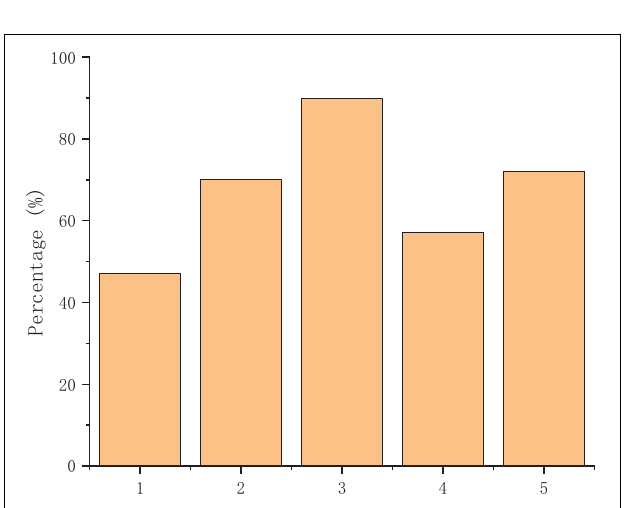
FIGURE 7 | Achievements of the hybrid learning of MOOCs [(1) deepening the feelings with teachers and classmates; (2) improving autonomous learning ability; (3) expanding the knowledge; (4) improving the ability to solve problems; and (5) mastering the new way of